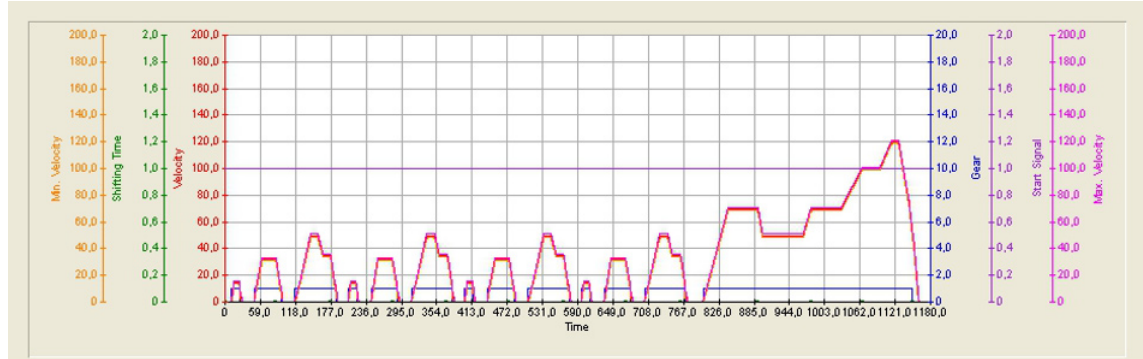
Figure 3. The ECE-15 is one of 4 urban cycles of the